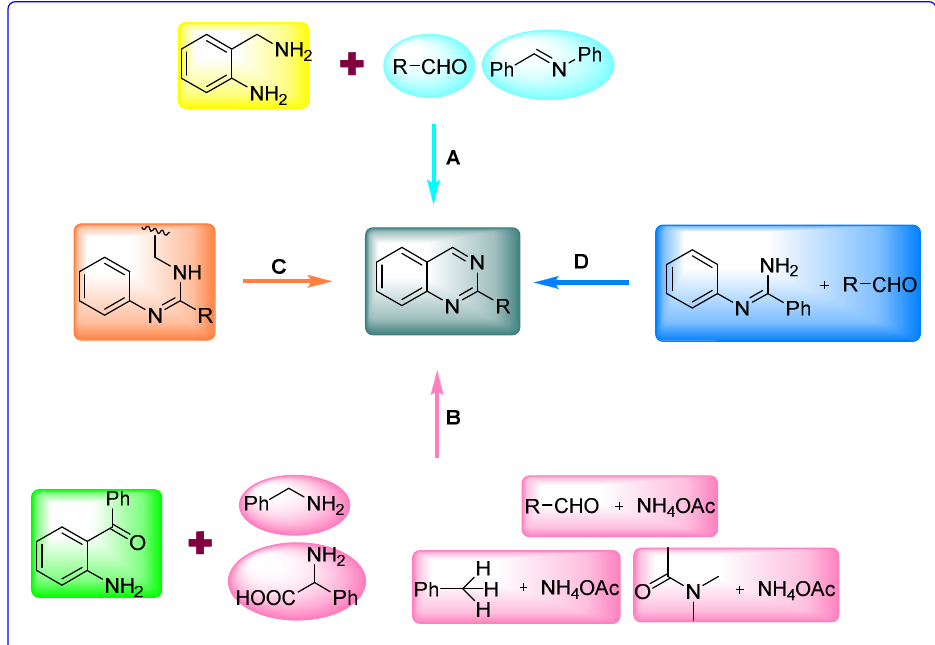
Figure 3. Classical strategies for the synthesis of quinazolines.